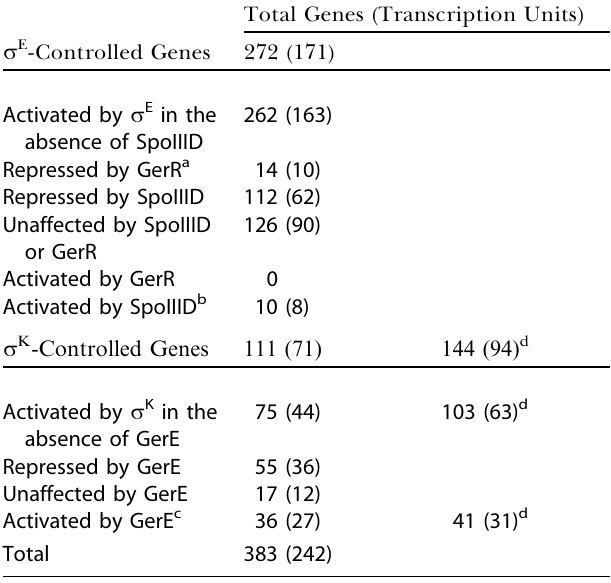
Table 2. Genes Activated in the Mother-Cell Line of Gene